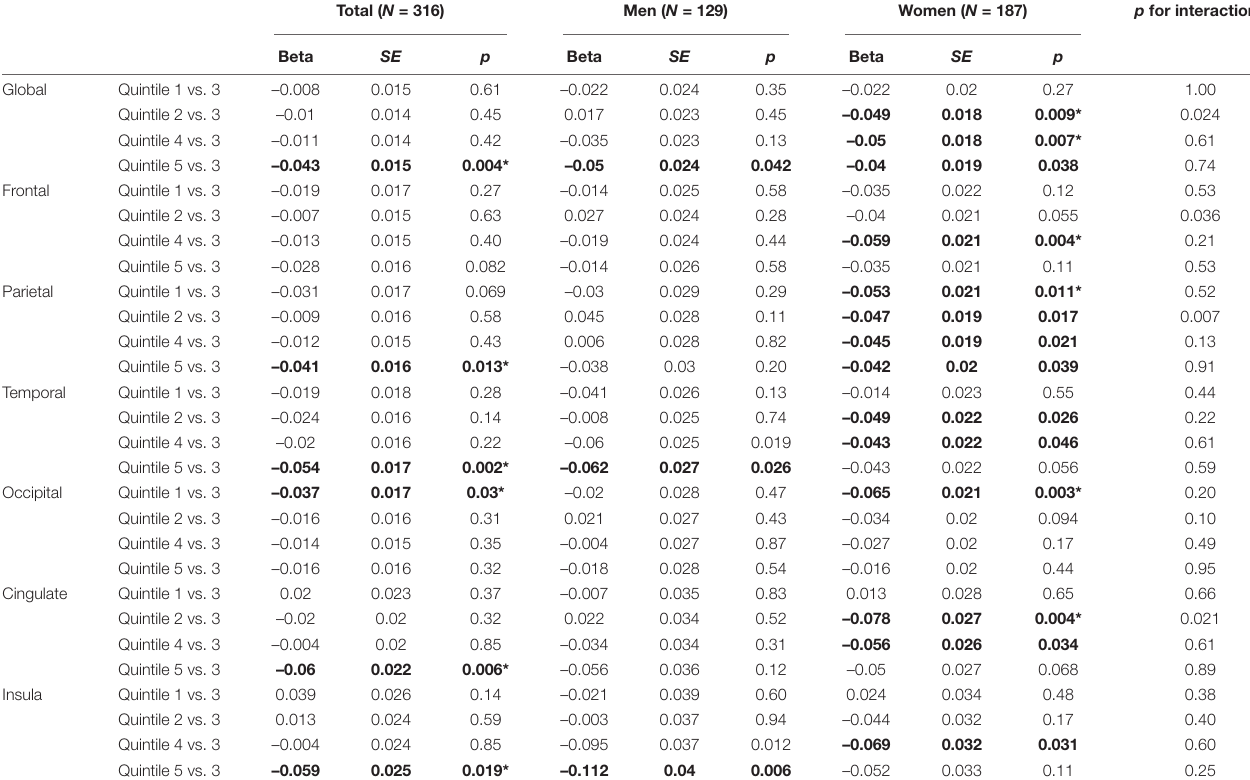
TABLE 3 | Association between visceral fat area and cortical